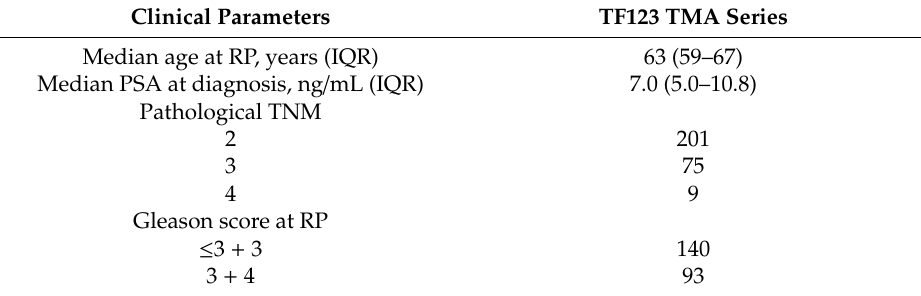
Table 1. Clinical and pathological characteristics of the 285 patients who underwent radical